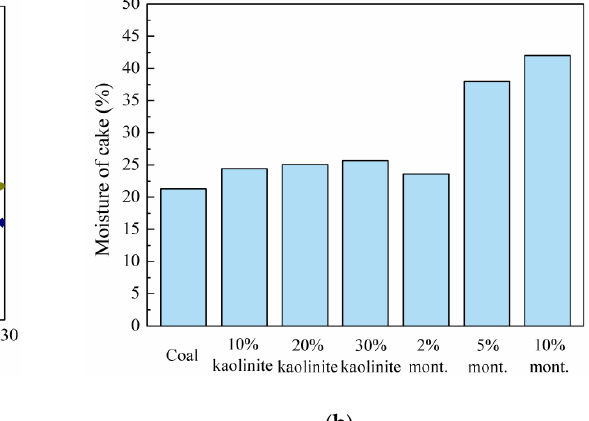
Table 3. Average specific resistance of different slurry